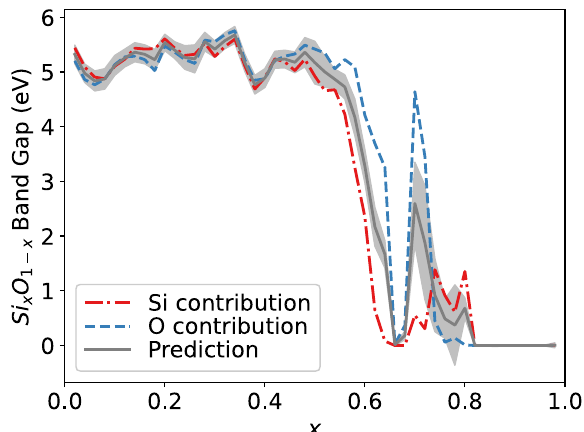
Fig. 5 Element contribution to property prediction as a function of composition. Model predictions over the Si x O 1 − x system using a model trained on the a fl ow__Egap data. The x -axis is the fractional amount of Si. The y -axis shows the predicted band gap value at a given composition. The blue and red lines are the individual element contributions to the prediction, as predicted by CrabNet . The gray shading represents the aleatoric uncertainty for each prediction.